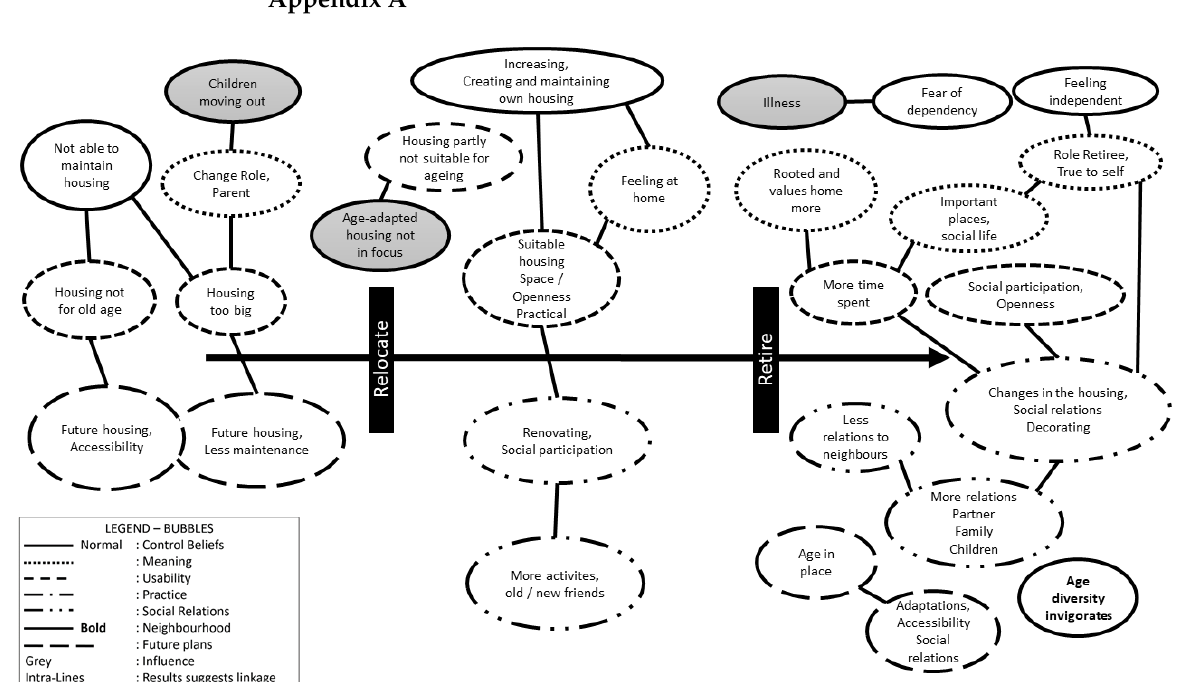
Figure A1. Joint situational map showing macrocodes in a timeline arrow for persons that had relocated before retirement. The legend shows aspects of perceived housing, influencing macrocodes, and suggested linkages between macrocodes.